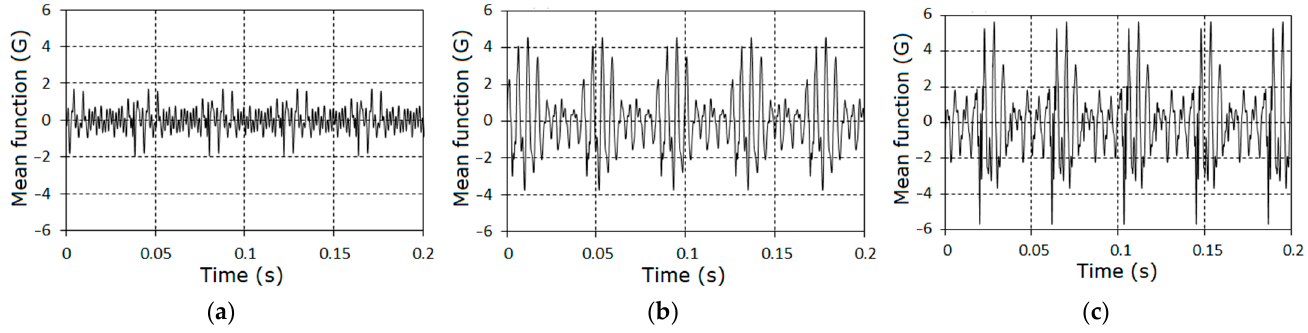
Figure 8. The mean function estimators of the vibration for the three stages ( a – c ) of gear tooth